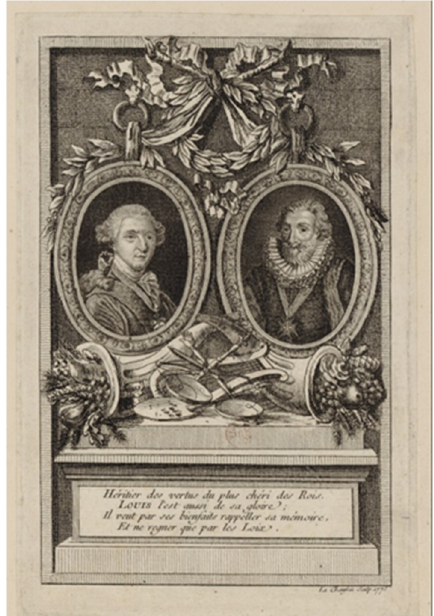
Figure 11. La Chaussee (France, unknown dates), Portraits de Louis XVI et de Henri IV dans deux Mé- daillons Suspendus au-dessus de Deux Cornes d‘Abondance , 1775, Engraving, Bibliothèque nationale de France, Département Estampes et Photographie; Collection Michel Hennin, Estampes Relatives à l’Histoire de France. Tome 109, 9476–9572.